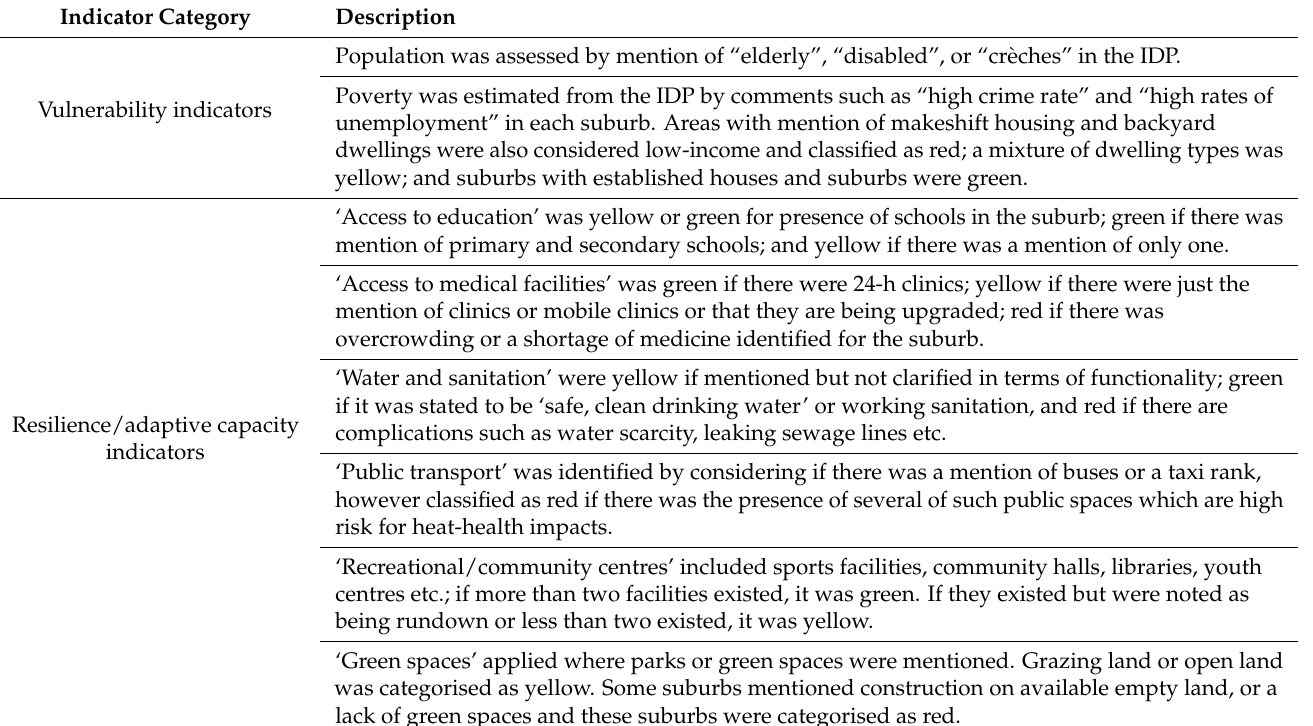
Table 1. Description of HEAT indicators for those pertaining to heat-related vulnerability and resilience.